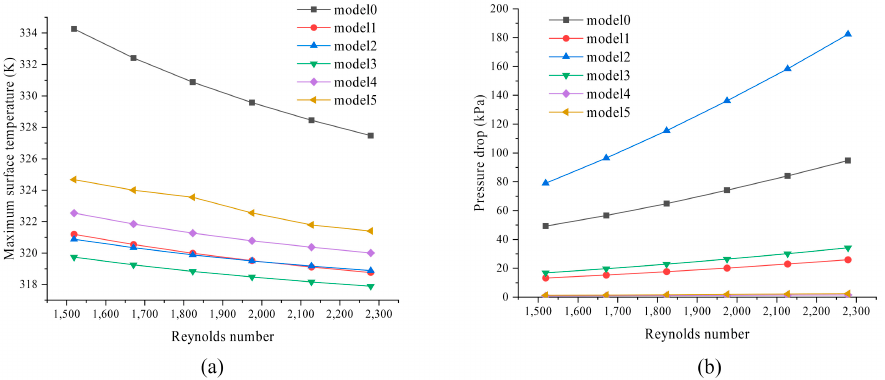
Figure 11. Effect of Reynolds number on heat transfer characteristics. ( a ) Maximum surface temperature, ( b ) pressure drop.